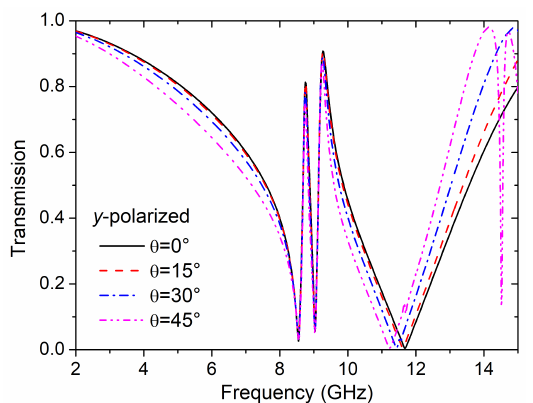
Figure 8: Transmission spectra of the proposed dual-band polarization independent EIT-like metamaterial for oblique angle of incidences under x -polarized